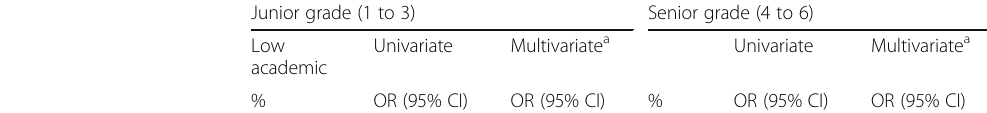
Table 3 Logistic regression analyses on low academic performance by grade n =